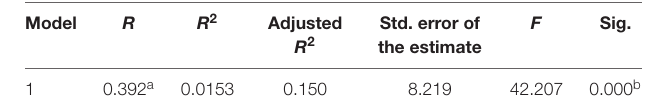
TABLE 4 | Regression model and the associated